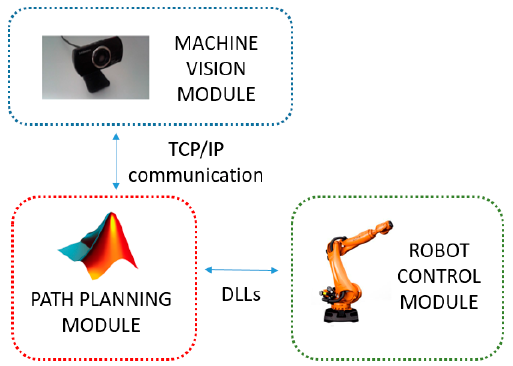
Figure 1. Overview of the proposed system. Three modules running simultaneously in parallel: (i) machine vision (smart sensing), (ii) path planning (reasoning, decision making), and (iii) robot control (movement coordination).